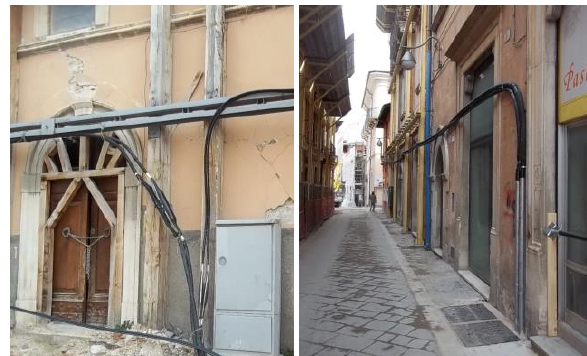
Figure 5. On the left, the temporary by-pass related to the data network (prepared by Telecom and Fastweb); on the right, the one related to the water network